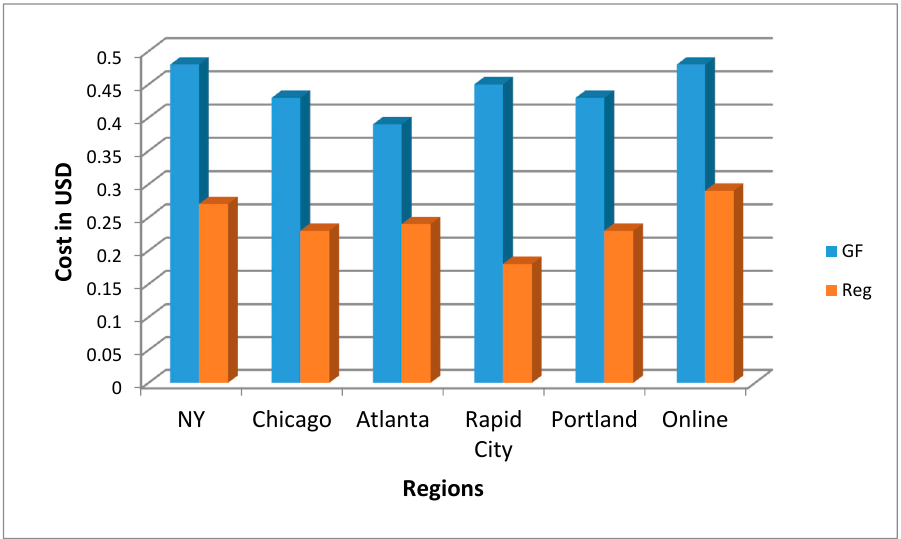
Figure 3. Differences in cost by region, price per ounce ( p < 0.001).